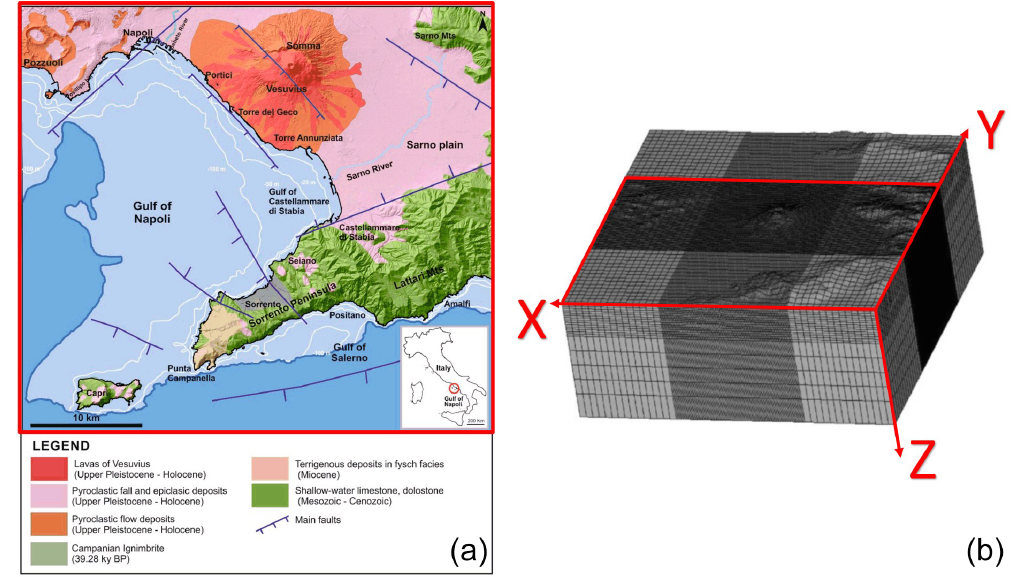
Figure 1. (a) Geological map relating to the part of the domain enclosed in the red box (from Pennetta, 2018). It includes Gulf of Napoli and the Somma-Vesuvius volcano, southern Italy. Inset shows a geographical sketch of southern Italy, the circle indicates study area. (b) Finite el- ement model used in this study. The directions of the y -axis and x -axis coincide with the geographic North and East-West verse, respectively. The z -axis is perpendicular to the x − y plane.